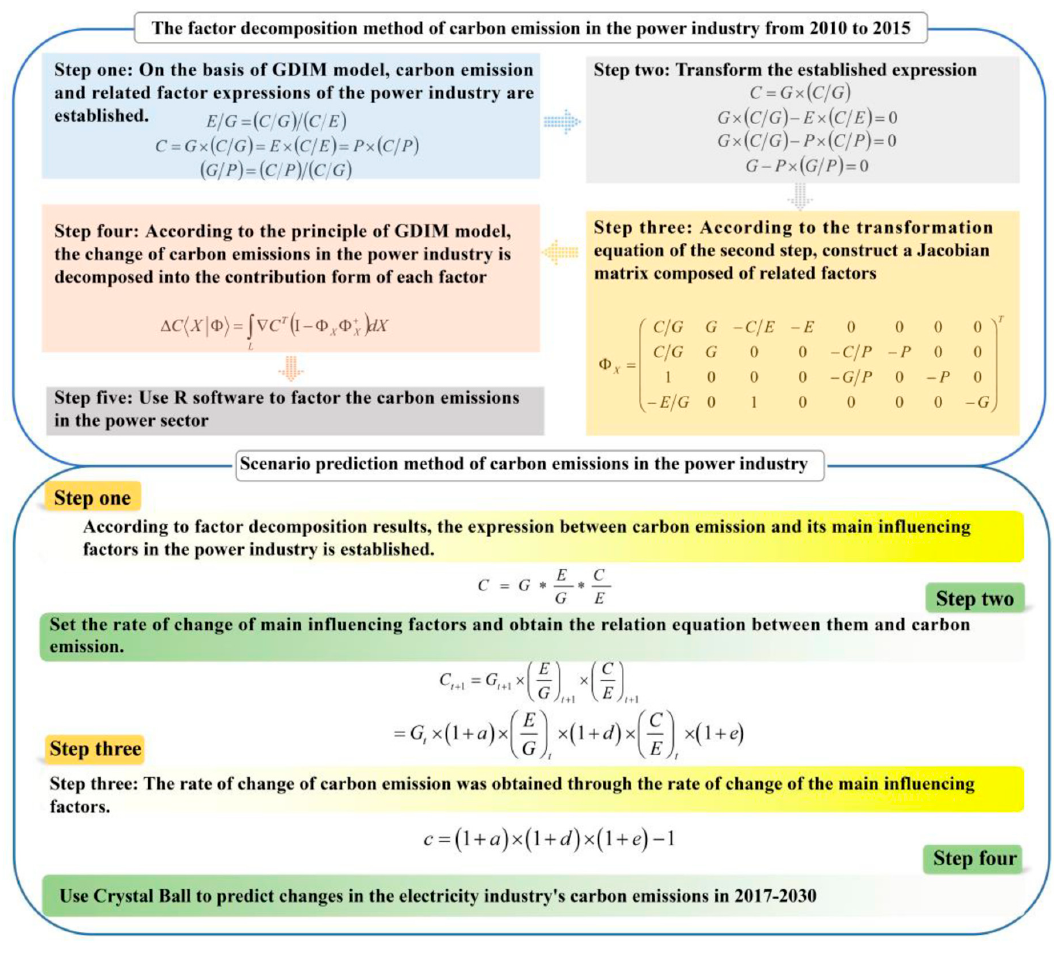
Figure 1. The summary of research methods and models.